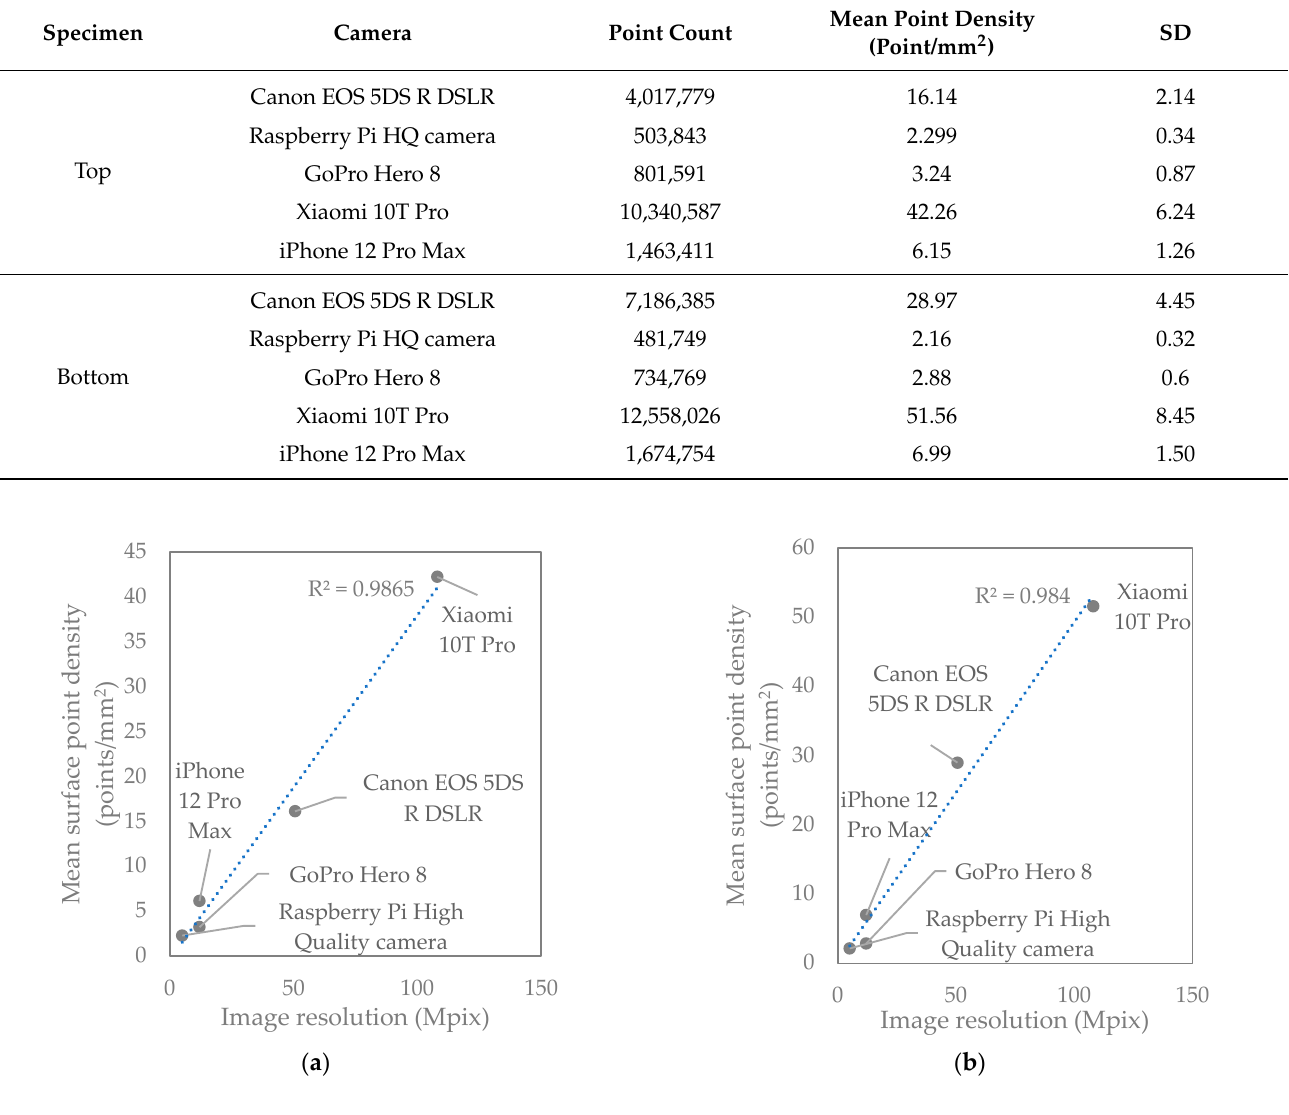
Table 5. Mean surface point density of the 3D point clouds of the fracture surface.